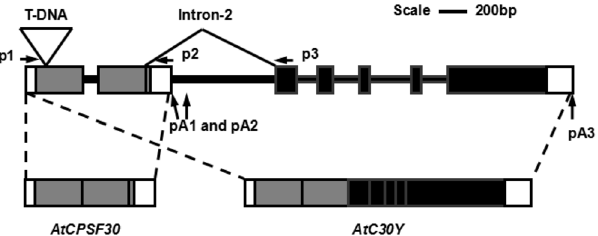
Figure 1. The structure of the OXT6 gene and RNA transcripts. Exons are indicated in gray or black boxes, UTRs are indicated in white boxes, and introns are indicated in thick lines. The position of the T-DNA insertion in the oxt6 mutant is indicated above Exon-1. The polyadenylation regions inside Intron-2 (pA1 and pA2) and 3 ′ UTR (pA3) are indicated with arrows. Positions of primers used for quantitative RT-PCR are labeled above the OXT6 gene. Primers p1 and p2 are used to detect AtCPSF30 transcript, while primers p1 and p3 are used to detect AtC30Y transcript. This figure is adapted from 14 with